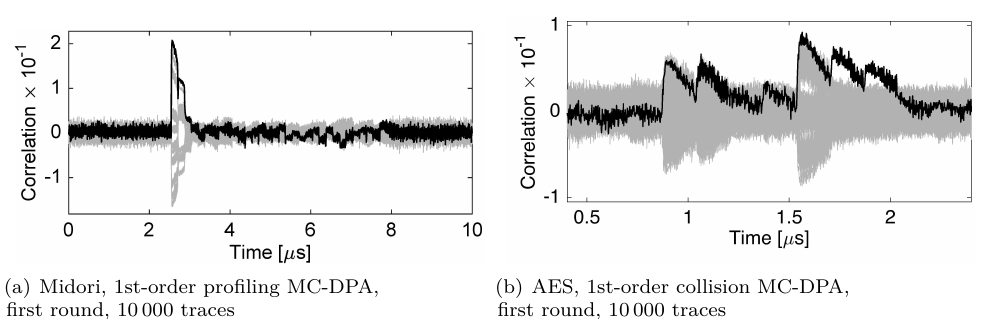
Figure 10: Experimental analysis with initial masking turned